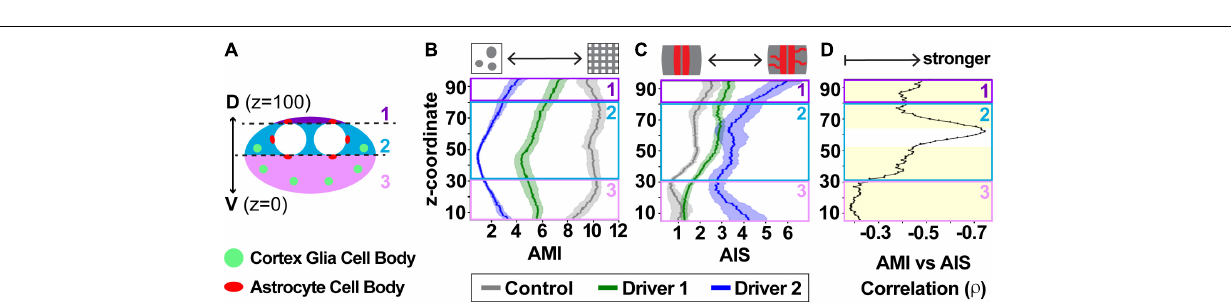
FIGURE 6 | Astrocyte infiltration significantly correlates with disrupted cortex glial morphology. (A,B) As cortex glial (CG) morphology becomes more impaired, shown by reduced automated morphology index (AMI, in A ), the automated astrocyte infiltration score (AIS) increases (B) . Kruskal–Wallis test comparing all groups, followed by Dunn post hoc pairwise comparisons. ** p < 0.01, *** p < 0.001, **** p < 0.0001. (C) AIS and AMI are significantly correlated, as indicated by Spearman’s rank correlation coefficient ( ρ = –0.668, p < 0.0001). Scores for individual images of each CNS were grouped and averaged by animal. Control n = 27, Driver 1 n = 34, Driver 2 n = 22 animals.